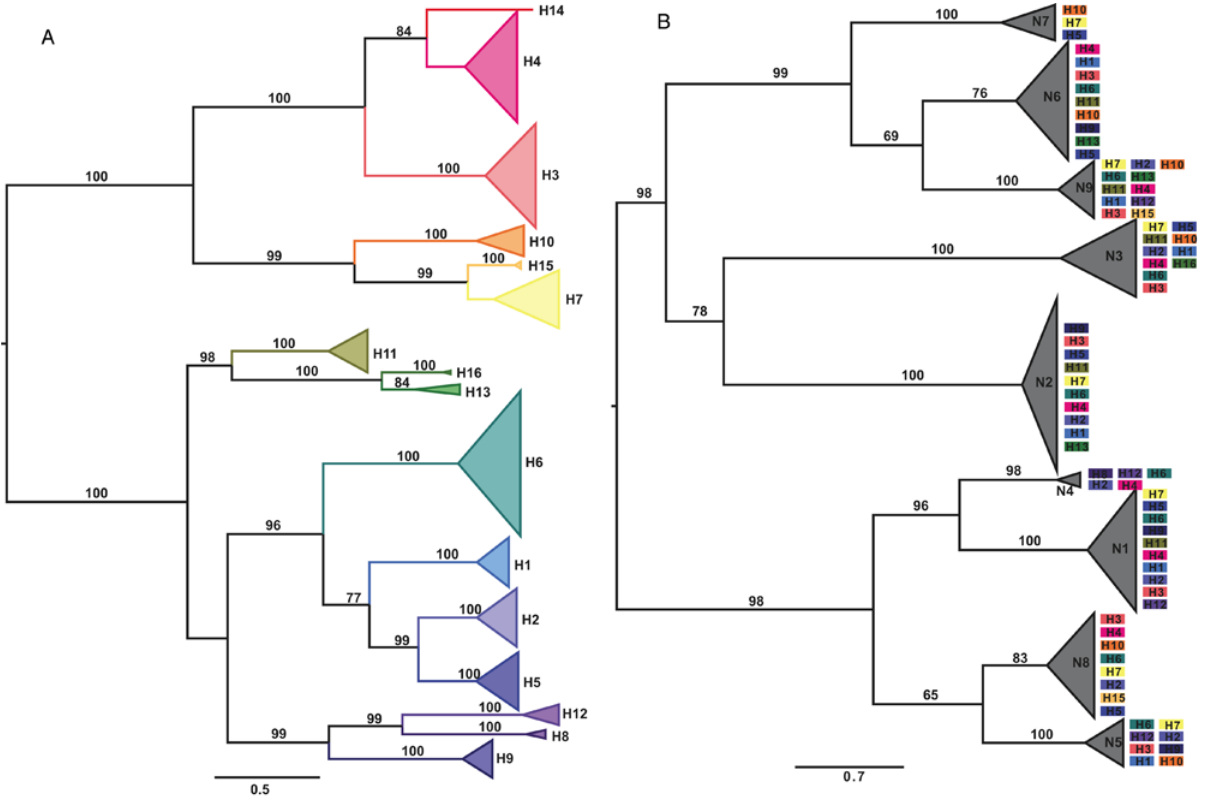
Figure 1. Maximum likelihood trees of HA and NA genes. (a) Maximum likelihood tree of the HA gene segment of 452 isolates of avian influenza A virus, including representatives of all 16 subtypes. For clarity, all branches within individual subtypes have been collapsed and color- coded to signify individual subtypes. Bootstrap values above 70% are shown next to relevant branches. Branch lengths are scaled according to the number of nucleotide substitutions per site. See Figure S1 for an expanded form of this tree. (b) Maximum likelihood tree of the NA gene segment of 473 isolates of avian influenza A virus, including representatives of all 9 subtypes. The mix of HA subtypes (color-coded according to Figure 1a) observed within each NA type is shown, highlighting the frequency of reassortment. For clarity, all branches within individual subtypes have been collapsed. Bootstrap values above 65% are shown next to the relevant branches. Branch lengths are scaled according to the number of nucleotide substitutions per site. See Figure S2 for an expanded form of this tree, in which individual viral isolates are